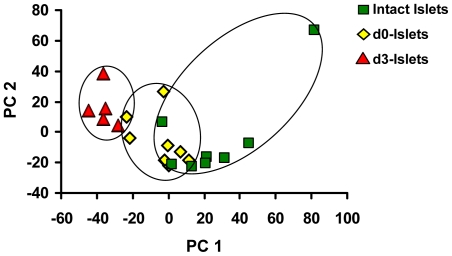
Principal Component analysis (PCA) plot of variability in whole genome expression from intact or isolated islets.Samples were distributed by their similarity in expression data using dimensionality reduction. Pancreatic intact islets (green dots) cluster at right whereas samples from d3-islets (red dots) cluster at left, apart from other groups. The freshly isolated islet samples (yellow dots) cluster at middle and partially intermix with other groups. Principal component 1 and Principal component 2 together accounted for 27% variation.